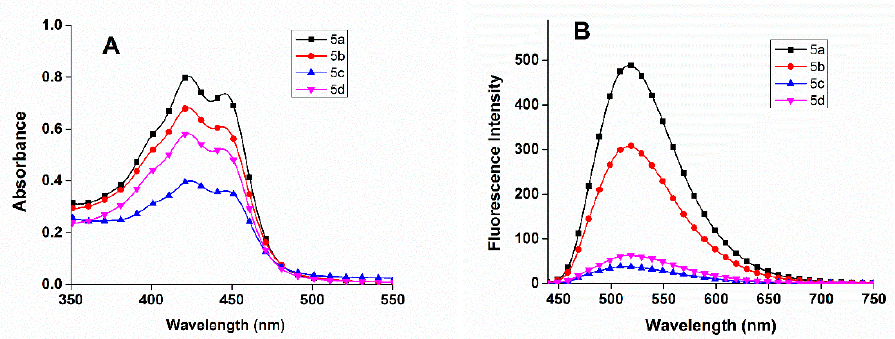
Figure 3. ( A ) Absorbance spectra of curcumin encapsulated samples in methanol; ( B ) emission spectra of curcumin encapsulated samples in methanol.